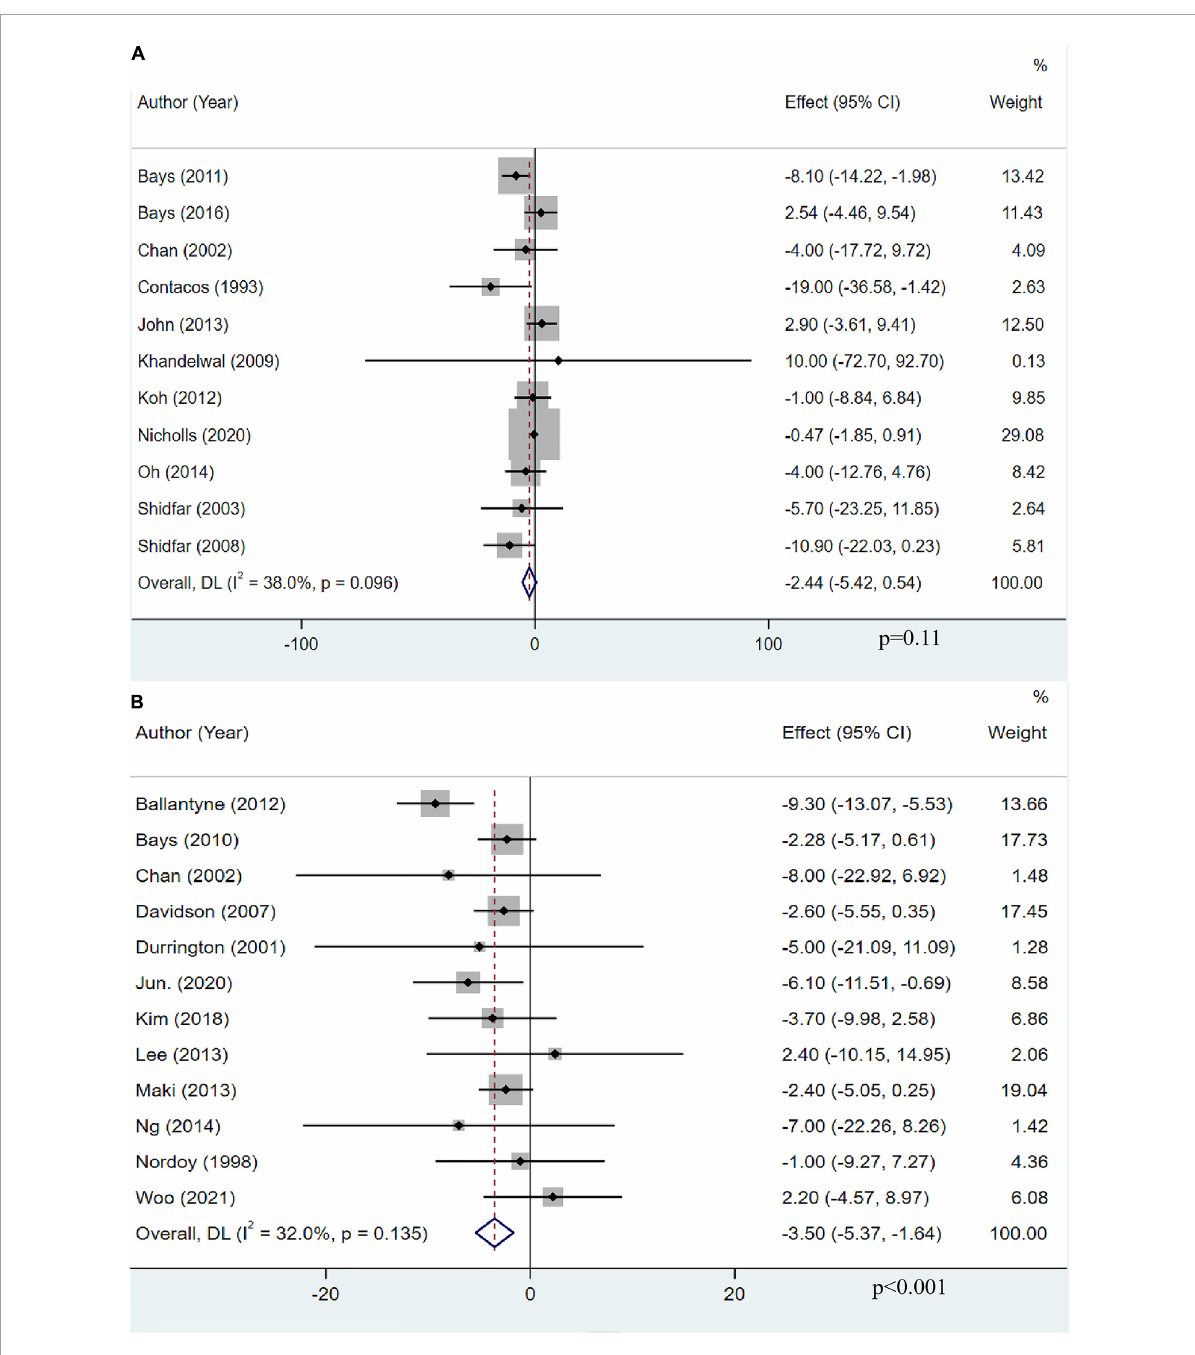
FIGURE9 The effect of OM3-FA on Apo-B. (A) OM3-FA monotherapy; (B) Combined therapy of statins plus